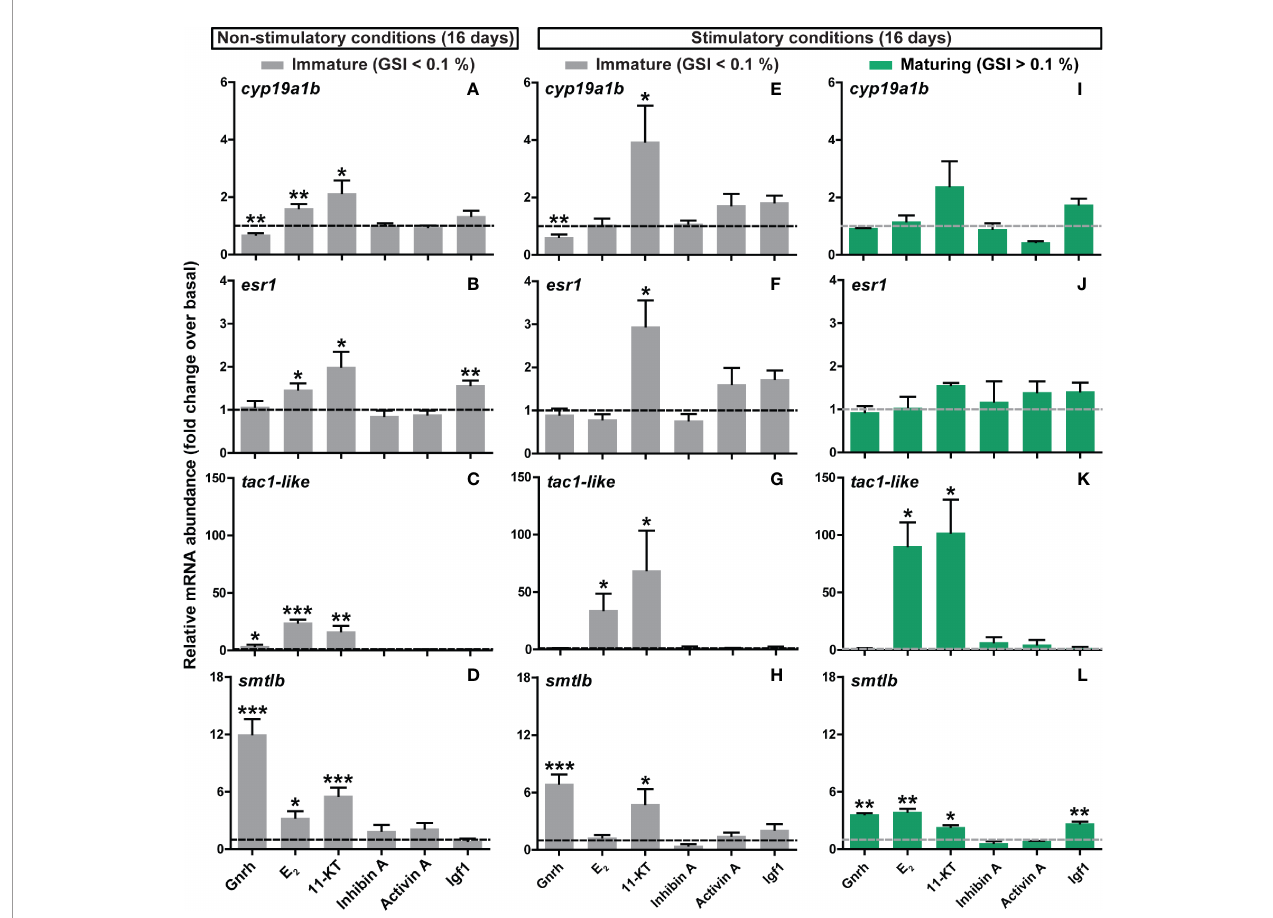
FIGURE 6 | Ex vivo effects of different ligands on selected pituitary genes identi fi ed by RNAseq. (A – D) Expression levels of steroid ( cyp19a1b , esr1 ), neurotransmission ( tac1-like ) and pituitary hormone ( smtlb ) genes in pituitaries collected from immature postsmolts exposed to standard photoperiod conditions and 16°C for 16 days, and subsequently incubated ex vivo for 9 days in the presence of various ligands. (E – L) The same set of candidate genes was analyzed in immature (E – H) and maturing (I – L) pituitary tissue after exposure to stimulatory conditions (constant light and 16°C) for 16 days, and subsequently incubated ex vivo for 9 days in the presence of the same ligands. Data are shown as mean fold change ± SEM (N = 4-11; *p < 0.05; **p < 0.01; ***p < 0.001) and expressed relative to the basal control group, which is set at 1 (dashed